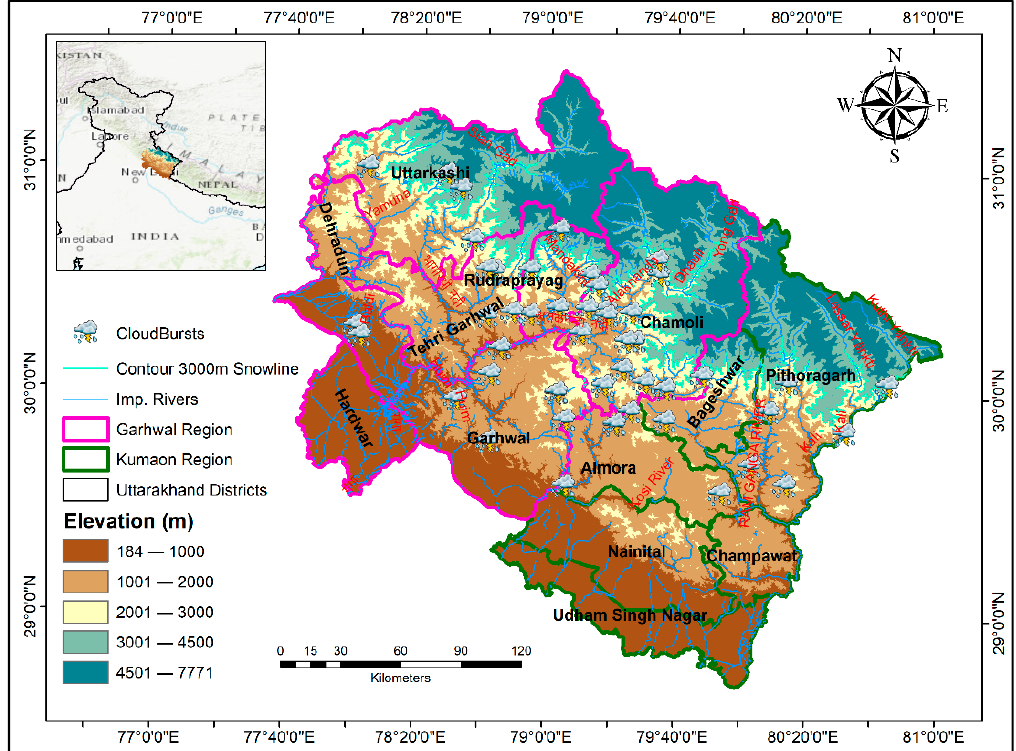
Figure 1. Map of Uttarakhand showing district, regions, and locations of cloudbursts.